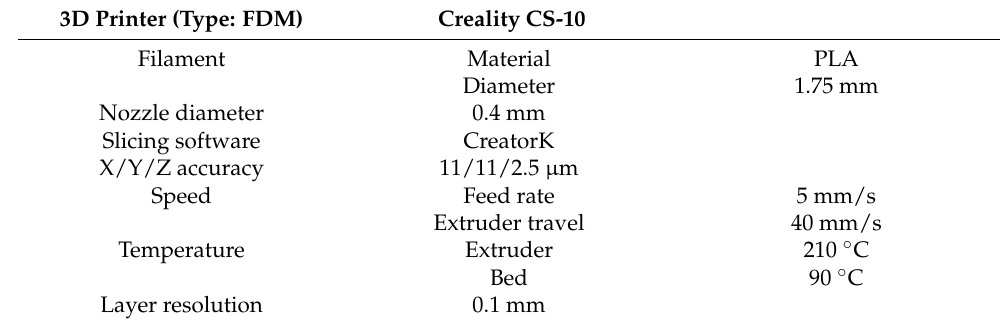
Table 1. The 3D Printer experimental conditions. 3D Printer (Type: